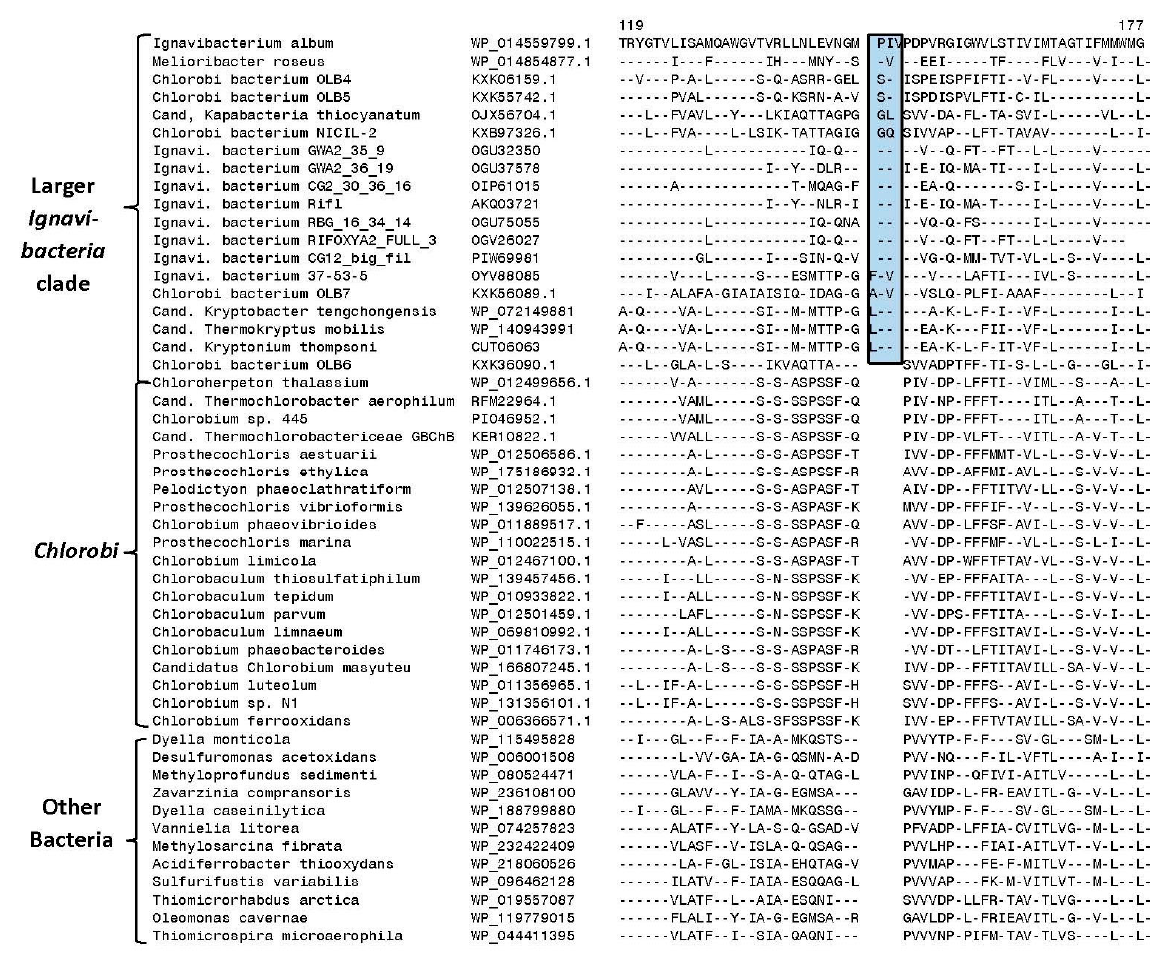
Figure 7. Partial sequence alignment of the protein preprotein translocase subunit SecY showing a two-to-three amino acid insertion (boxed) in a conserved region that is specifically shared by most of the species/strains that are a part of the larger Ignavibacteria clade (Figure 1). This insert is not found in members of the class Chlorobia or different outgroup bacteria examined, indicating that the genetic change giving rise to this CSI likely occurred in a common ancestor of the Ignavibacteria clade of species/strains.